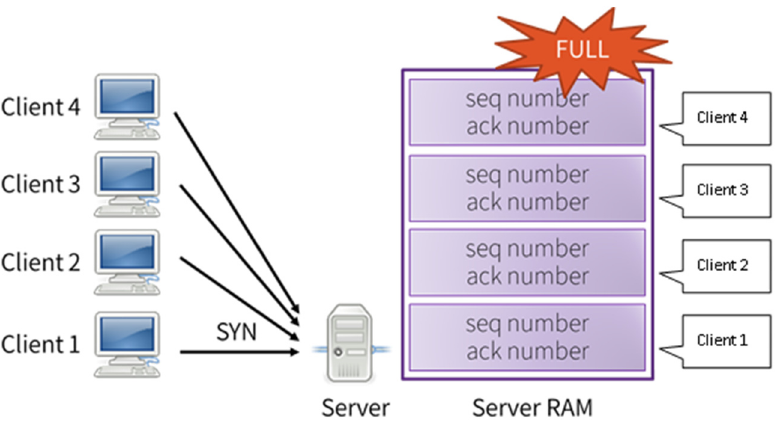
Figure 2. Illustration of SYN flood attacks.